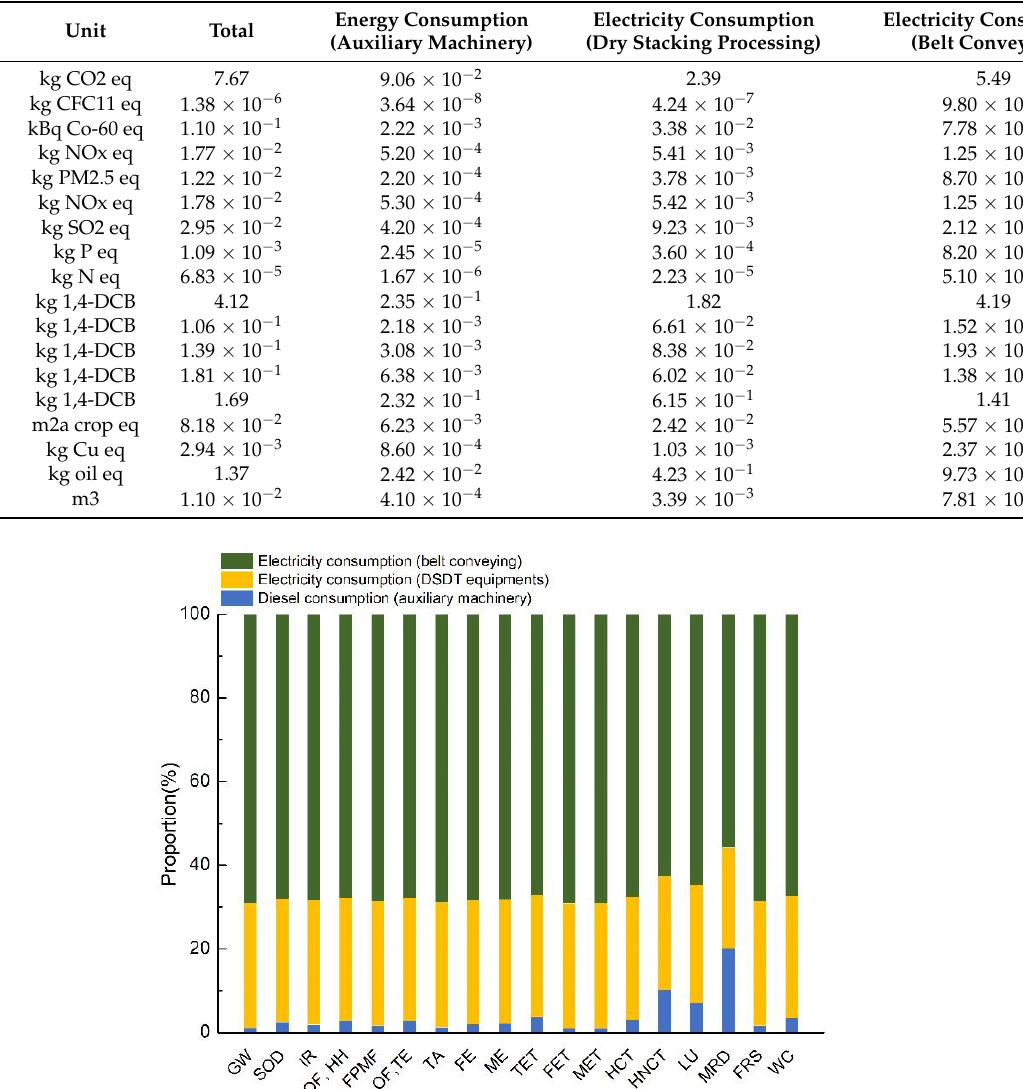
Table 5. Normalized LCA results for Scenario 2.